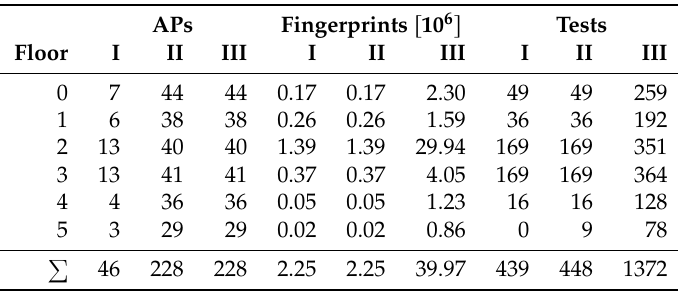
Table 1. Information about floors. The number of the measurement points, the numbers of the present and active APs, the number of the tests for each scenario